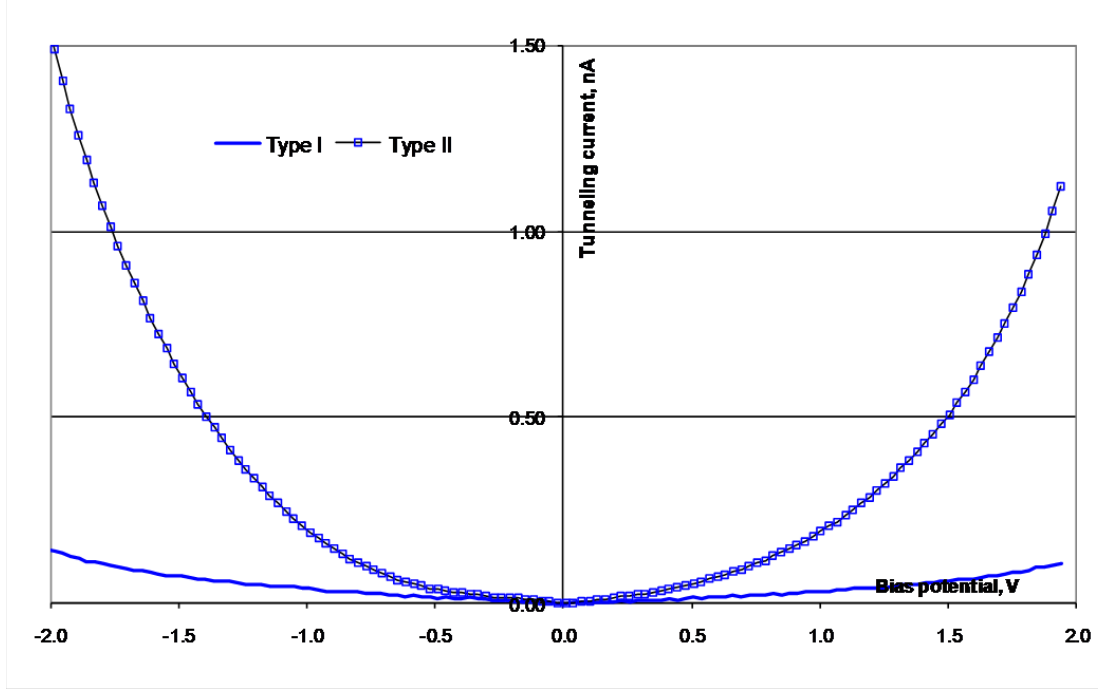
Figure 8. I(U) curves obtained from STS scans performed on the surface of Ni Mo Si B . The absolute value of the tunneling current is 70 20 5 5